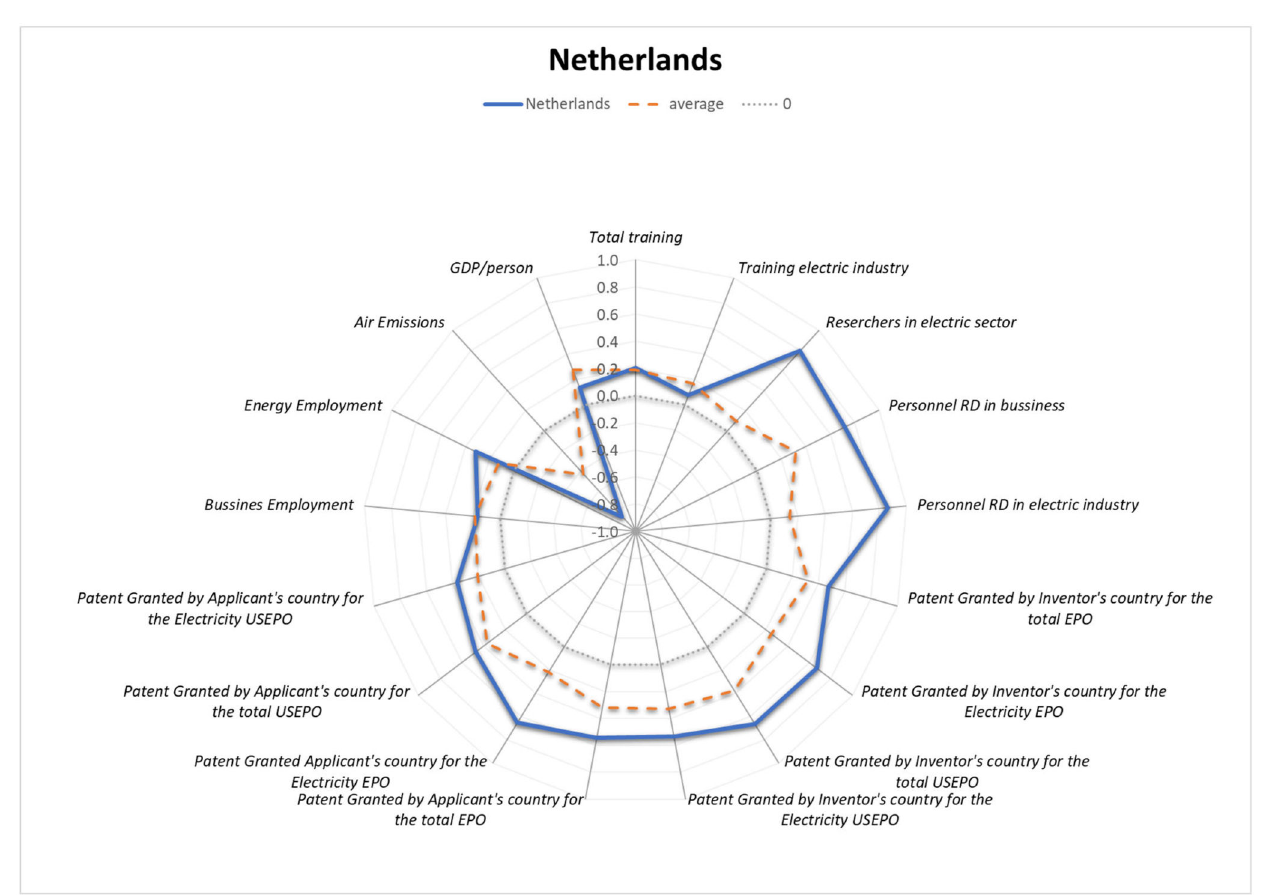
Figure 27. Synergy and trade-off occurrence—NL. Source: Authors’